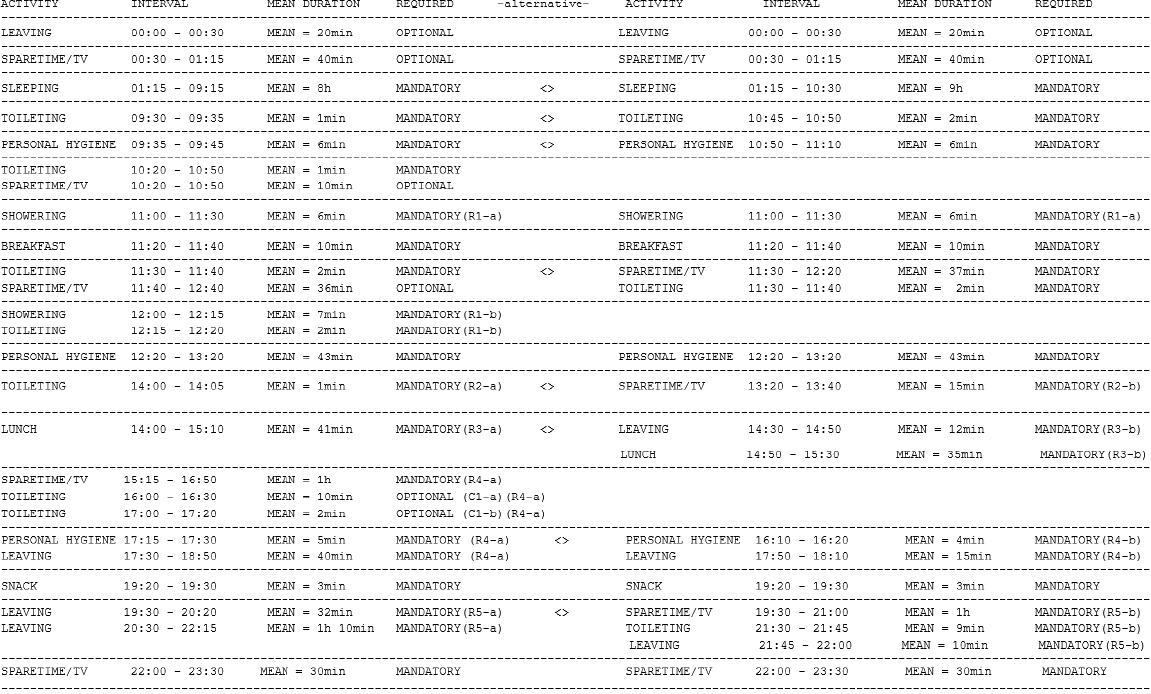
Figure 12. Example of flexible daily routine identified for a person for a full day (24 h).